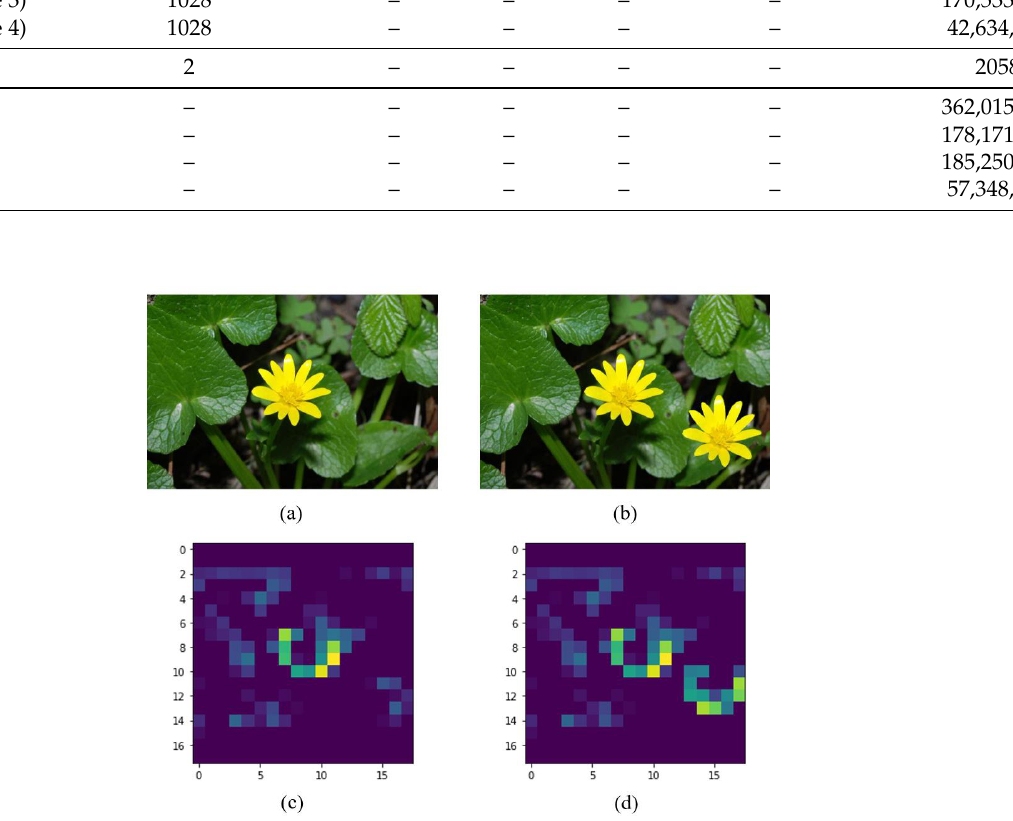
Figure 3. Example of feature maps for the block4_pool of the pre-trained VGG-16 model: ( a ) original image, ( b ) fake image with copy-move, ( c ) output of the filter 60 for the original image, ( d ) output of the filter 60 for the fake image. The source of ( a , b ) is [23] with permission of the